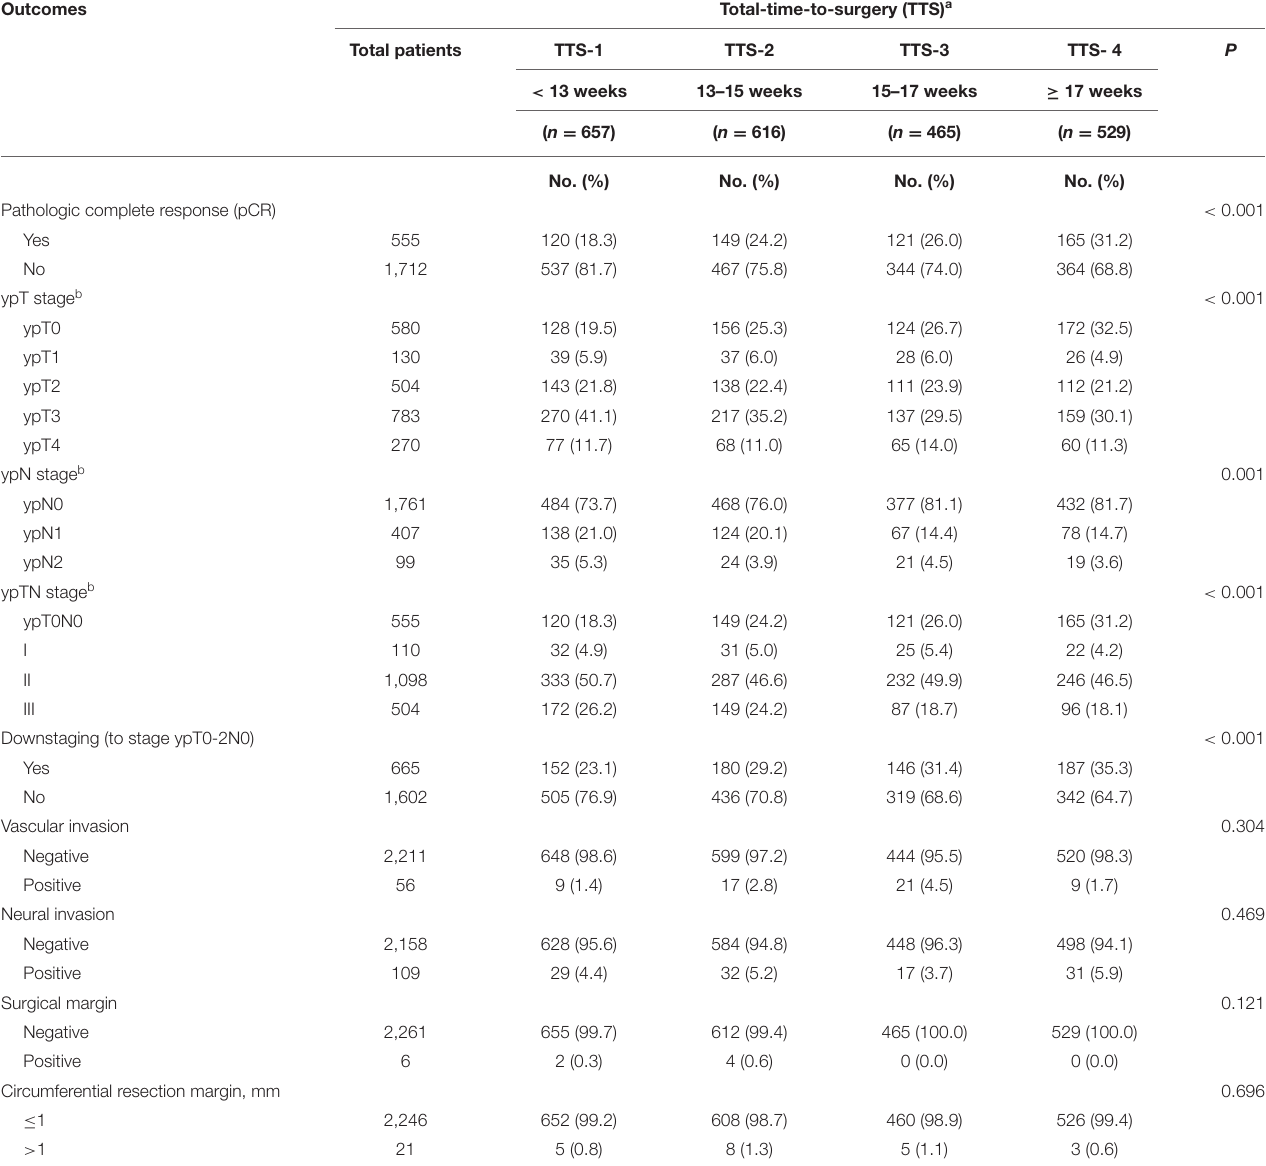
TABLE 3 | Clinicopathological outcomes, by total-time-to-surgery (TTS) a , of 2,267 patients with locally advanced rectal cancer, January 2010 through December 2018.